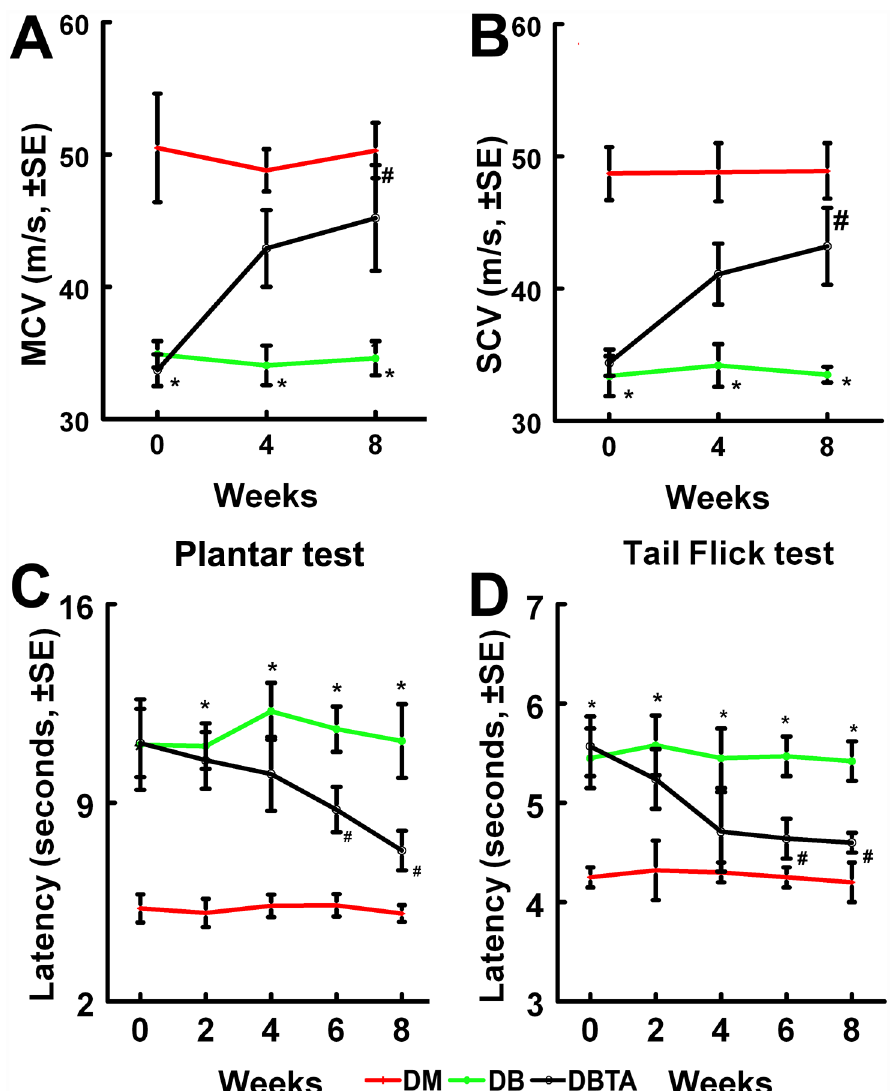
treated with tadalafil =